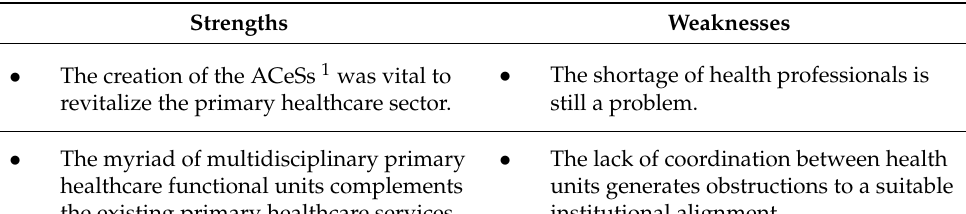
Table 1. SWOT analysis of the alignment of institutional interventions on the Portuguese pri- mary